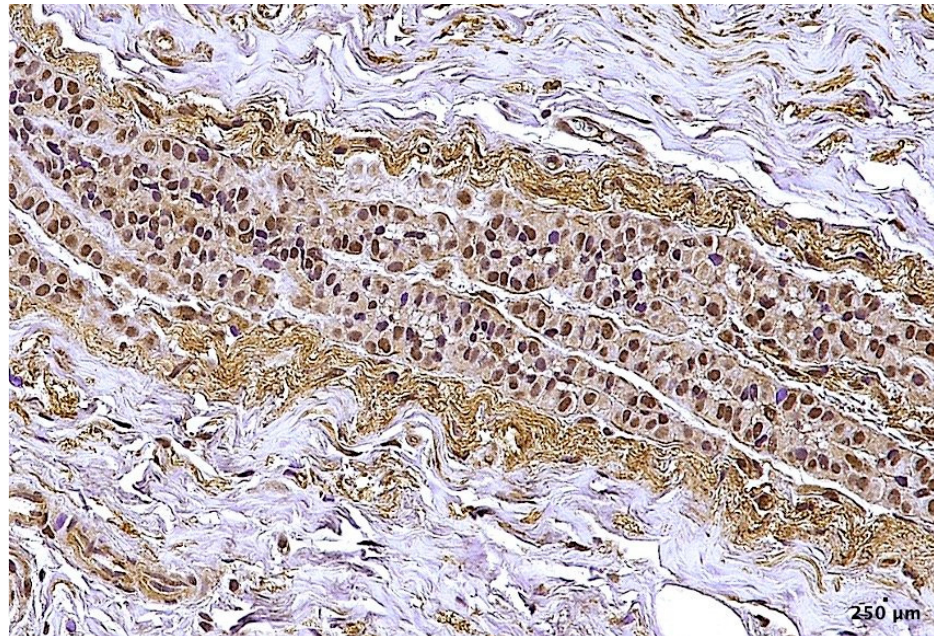
Figure 4. FOXO3a positivity in breast cancer. FOXO3a is localized both in the cytoplasm and nucleus (100x). The scale bar showed 250 μ m in distance.